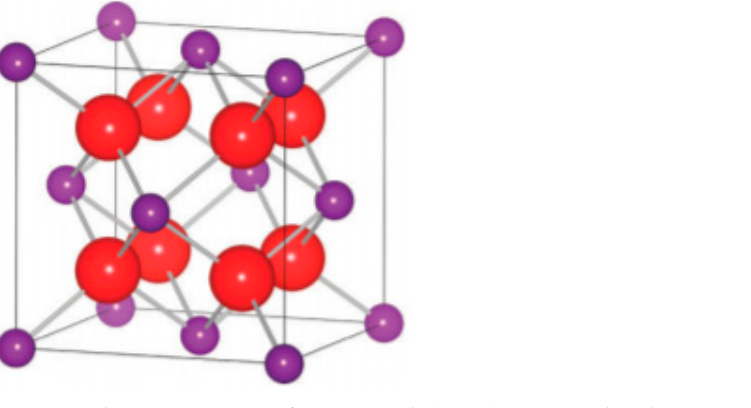
Figure 1. The FCC structure of cerium oxide (CeO 2 ). Reprinted with permission from [54], copyright Elsevier, 2010.